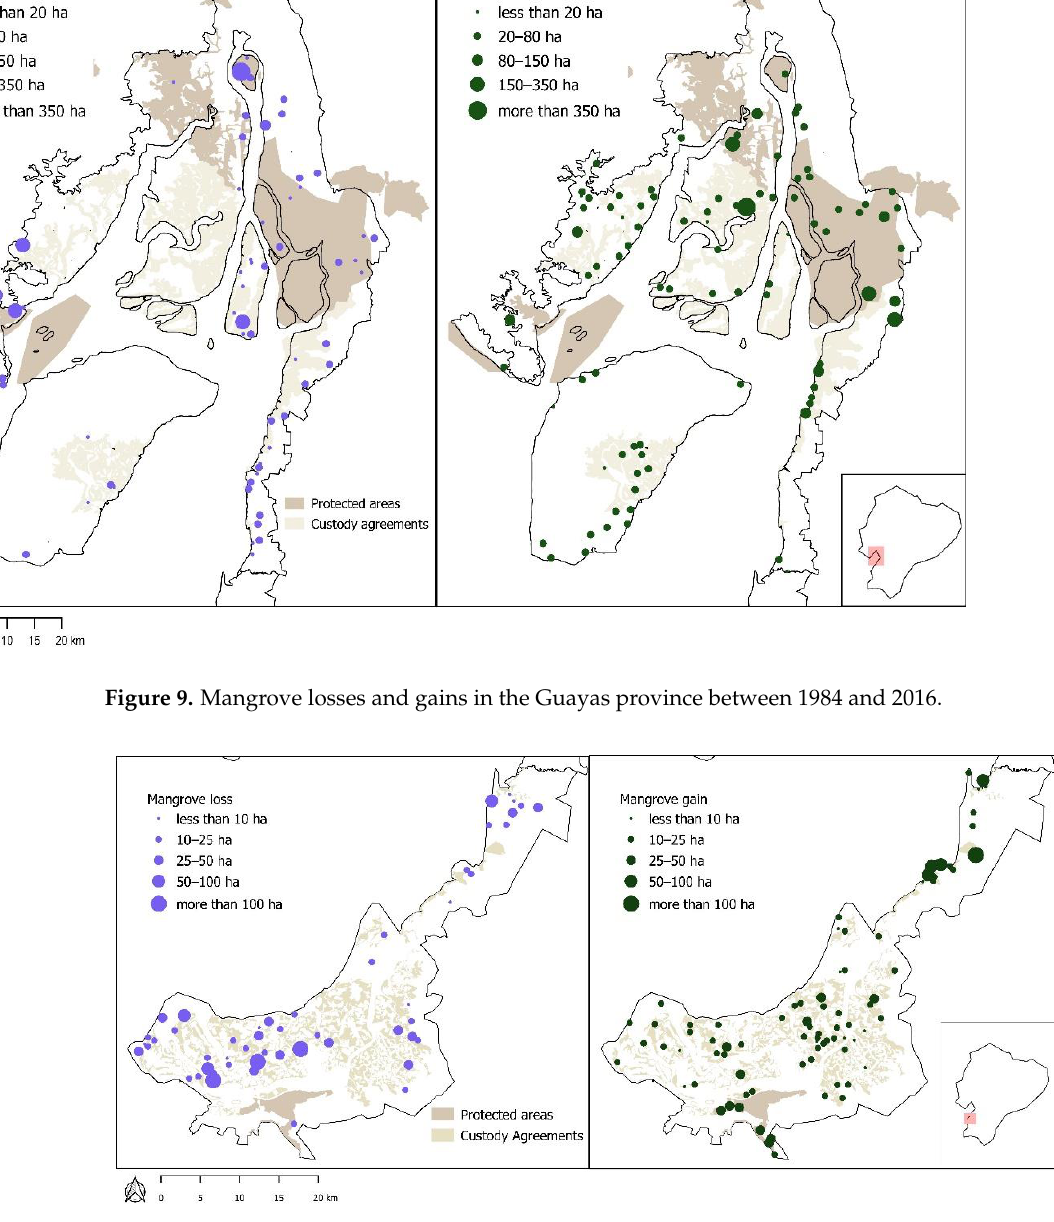
Figure 10. Mangrove losses and gains in the province of El Oro between 1997 and 2018.